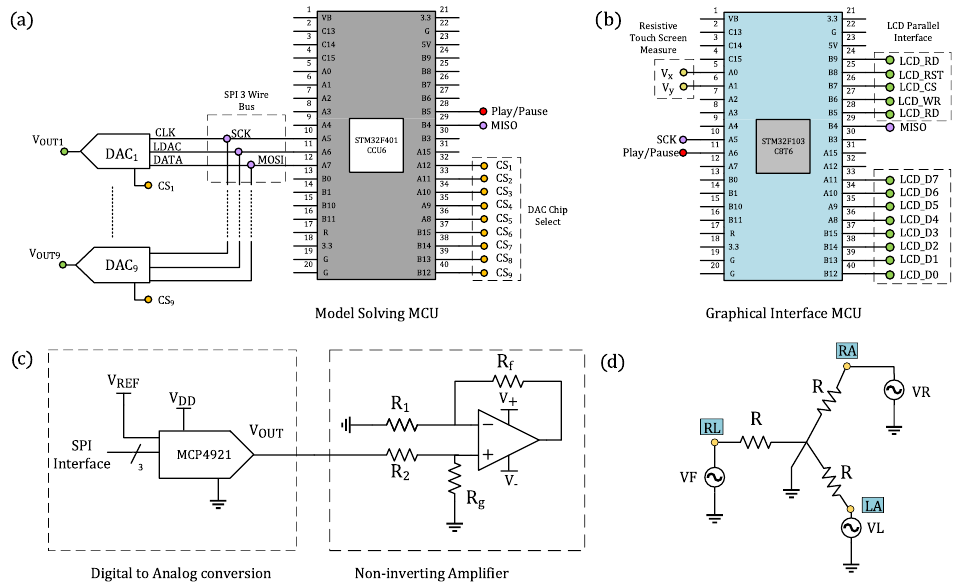
Figure 1. Electronic circuit of the ECG patient simulator. Schematics for ( a ) the STM32F401CCU6 microcontroller, managing the generation of ECG waveforms; ( b ) the STM32F103C8T6 microcon- troller, driving the communication protocol with the TFT LCD touch screen; ( c ) digital-to-analog conversion and amplitude regulation of synthetic ECG waveforms; and ( d ) Wye resistor network used to generate electrical potentials from limb